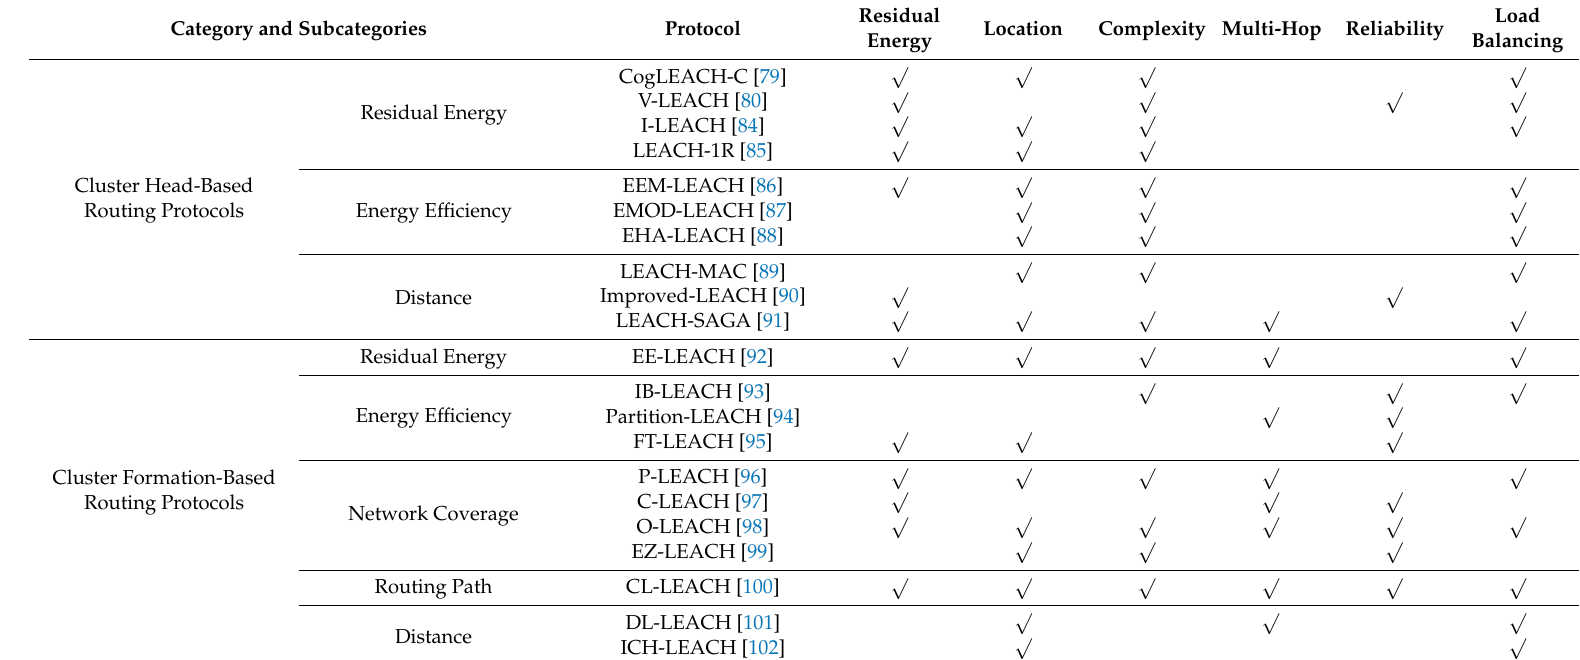
Table 11. Comparison of routing protocols in WSNs based on different